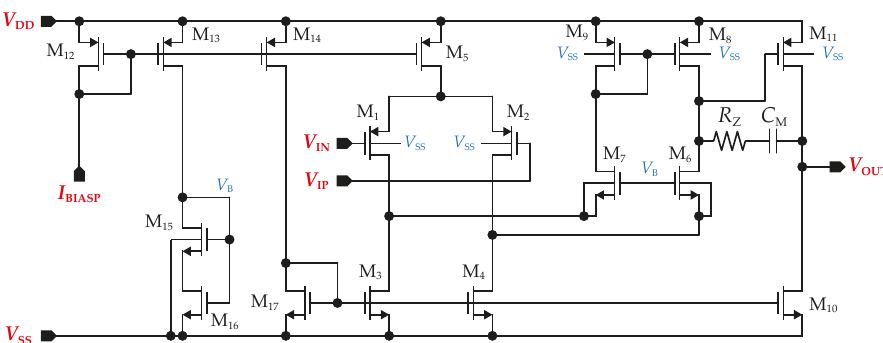
Figure 5. Topology of proposed operational amplifier utilized in active grounding and shielding